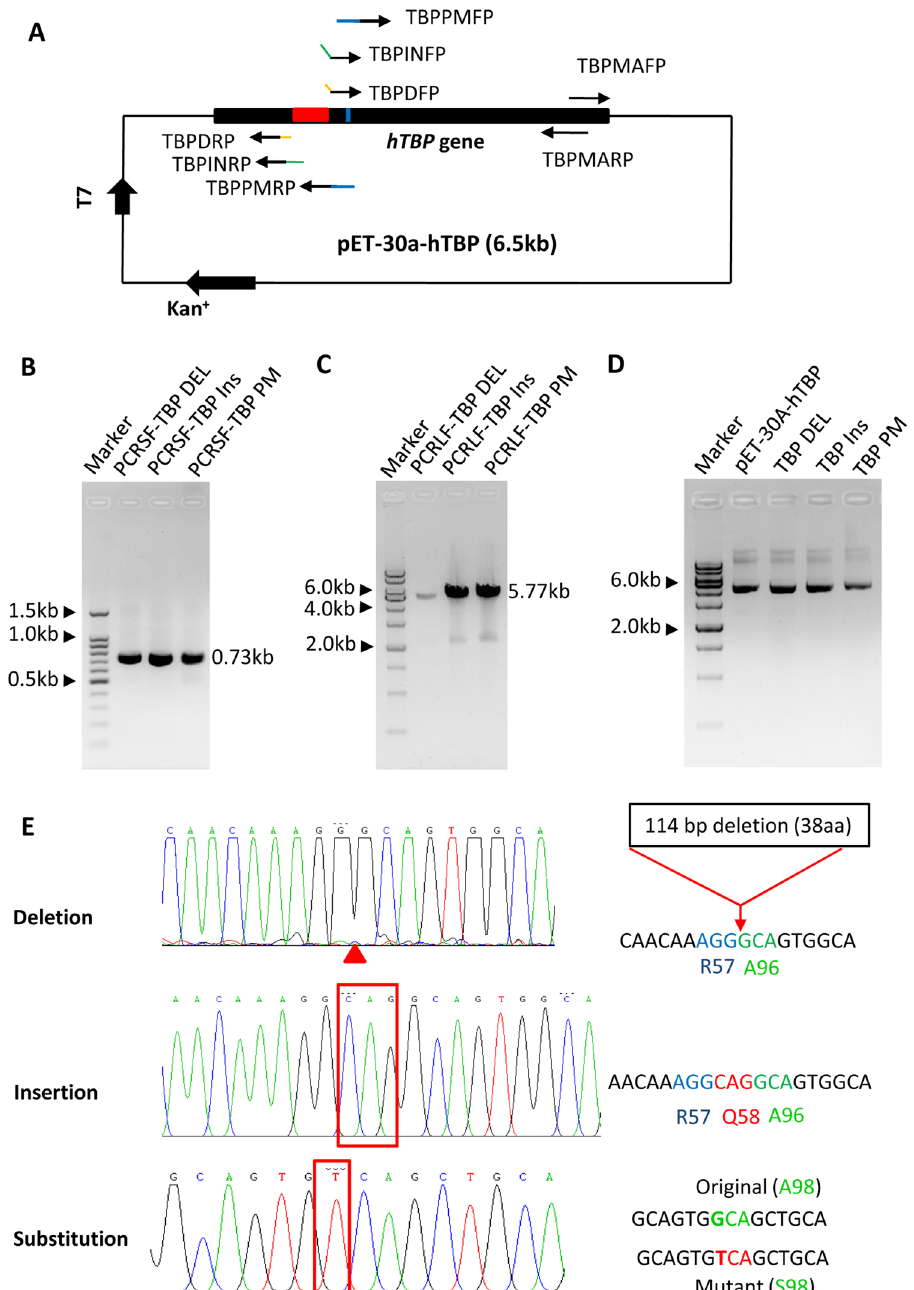
Figure 9. The SMLP method can be applied to the mutagenesis of deletion, insertion and point substitution for small plasmids. ( A ) A diagram showing the pET-30a( +)-hTBP plasmid and the positions of the PCR primers designed for deletion, insertion, and substitution mutations. The red region represents a deletion fragment, the blue short line represents a point mutation site, and the green short line represents the insert bases. ( B ) Analysis of the small DNA fragments from PCR by agarose gel electrophoresis. PCR was performed using the primer TBPMARP and one of the mutation forward primers, including TBPDFP, TBPINFP, and TBPPMFP. PCR products were detected by agarose gel electrophoresis. TBPMARP represents a TBP mutation-assisting reverse primer; TBPDFP, TBP deletion forward primer; TBPINFP, TBP insertion forward primer; TBPPMFP, TBP point mutation forward primer. ( C ) Analysis of the large DNA fragments from PCR by agarose gel electrophoresis. PCR was performed using the primer TBPMAFP and one of the mutation reverse primers, including TBPDRP, TBPINRP, and TBPPMRP. PCR products were detected by agarose gel electrophoresis. TBPMAFP represents a TBP mutation-assisting forward primer; TBPDRP, TBP deletion reverse primer; TBPINRP, TBP insertion reverse primer; TBPPMRP, TBP point mutation reverse primer. ( D ) Analysis of the pET-hTBP plasmids from mutagenesis by the SMLP method using agarose gel electrophoresis. The plasmids from mutagenesis were detected by agarose gel electrophoresis. ( E ) The results of DNA sequencing for the mutants of TBP gene deletion, insertion and point substitution. The left panels are the DNA sequencing maps for the mutants of TBP deletion, insertion and point substitution. The deletion position is marked with a red triangle (top), whereas the insertion and point mutations were framed by the red rectangle lines (middle and bottom), respectively. The right panels are the DNA fragments from the sequence maps (right panel), where the amino acids flanking each mutation site are indicated. The original and mutated bases were displayed in green and red colours,